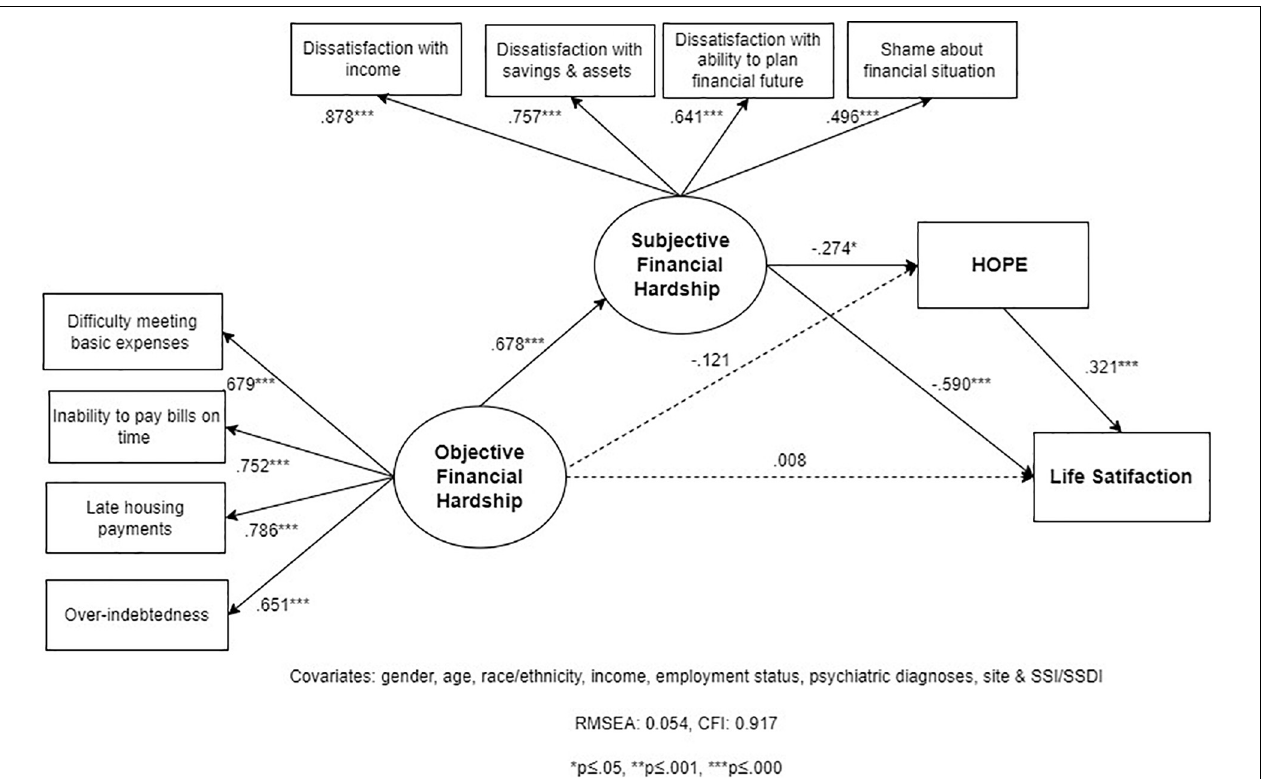
Frontiers in Psychiatry |